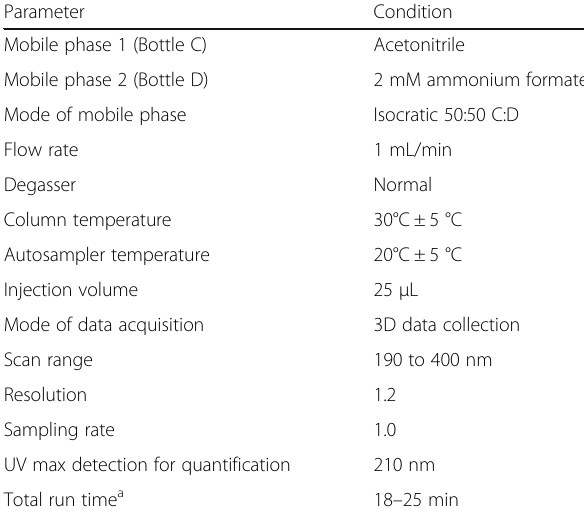
Table 1 Optimized conditions for